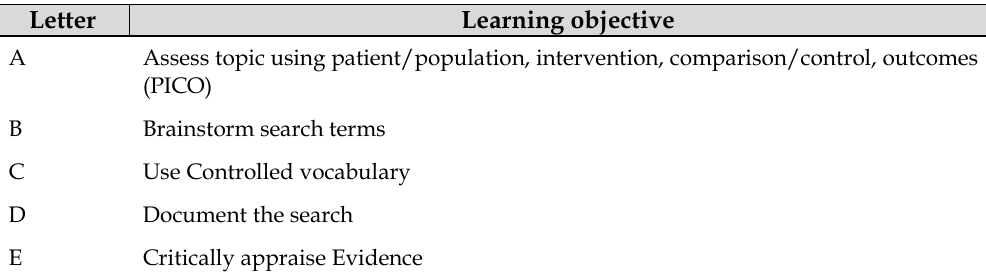
Table 2 Searching for evidence for quality improvement projects mnemonic Letter